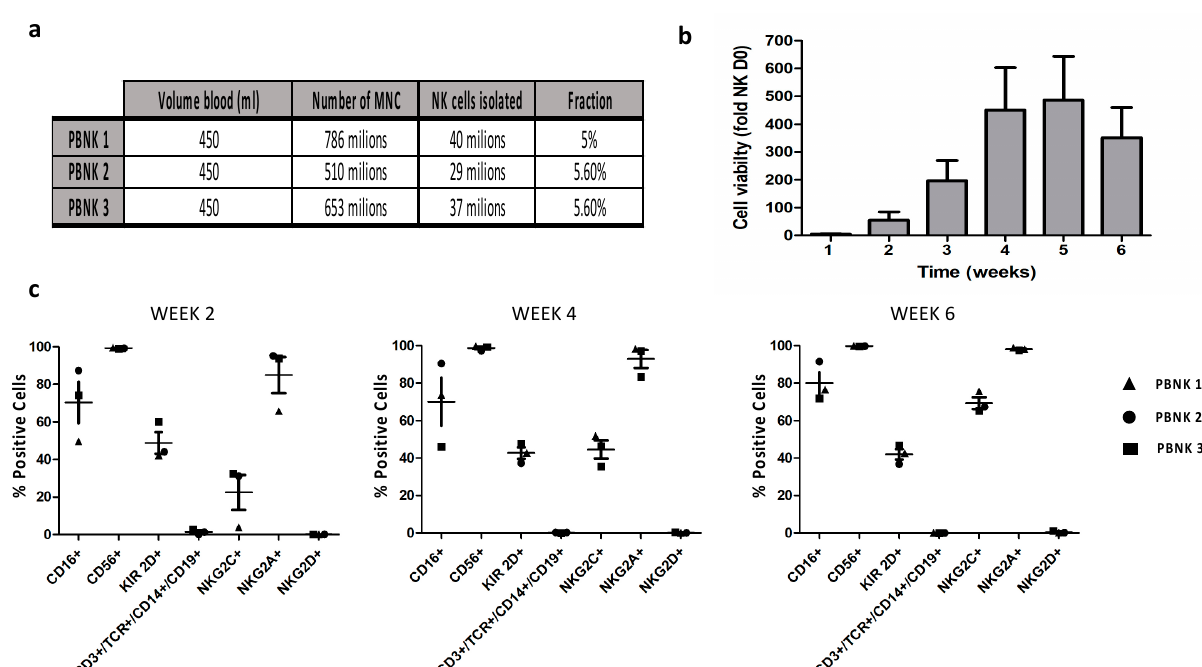
Figure 1. Isolation of NK cells, expansion to clinically relevant PBNK cell concentrations, and phenotype analysis. ( a ) A representative table with the yields of PBNK cells from three different donors using a negative selection approach. ( b ) Summary graph showing the median growth fold of the three PBNK cell donors isolated and expanded in the feeder-free NK MACS medium. ( c ) Representative graphics of PBNK cell purity obtained by FACS at the indicated number of days post-expansion. Data in ( b ) and ( c ) are means ± SEM of the three expanded PBNK cell donors.